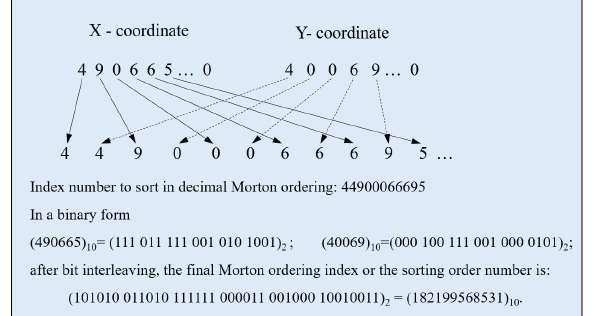
Figure 1: Example for the Morton Order sorting algorithm.